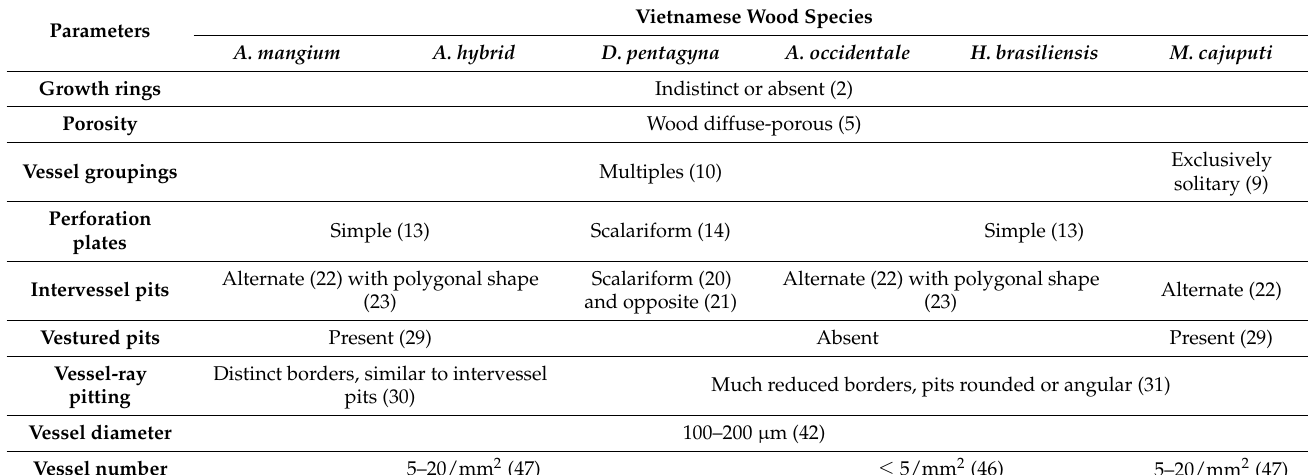
Table 2. Anatomical characteristics of Vietnamese wood species based on International Association of Wood Anatomist (IAWA) feature